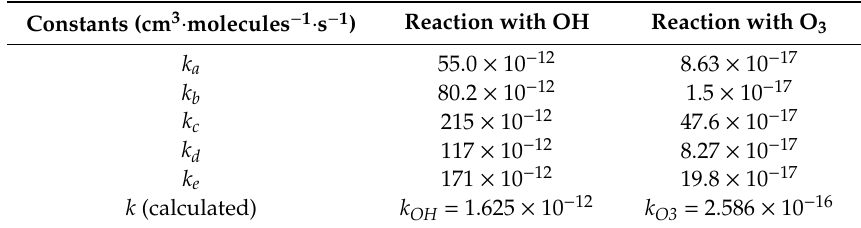
Table A1. Constants of reactivity with OH and O 3 and calculated k for reaction of monoterpenes with OH radical and O 3